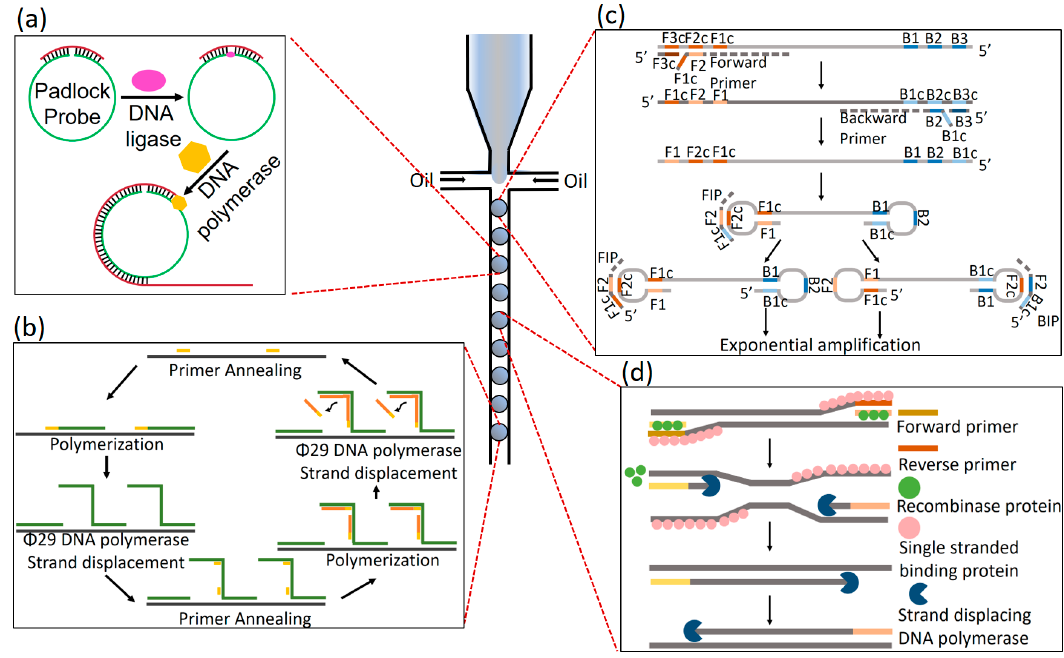
Figure 3. Schematic of isothermal amplification in a droplet. ( a ) Rolling circle amplification (RCA). ( b ) Isothermal multiple displacement amplification (IMDA). ( c ) Loop-mediated isothermal amplification (LAMP). ( d ) Recombinase polymerase amplification (RPA).